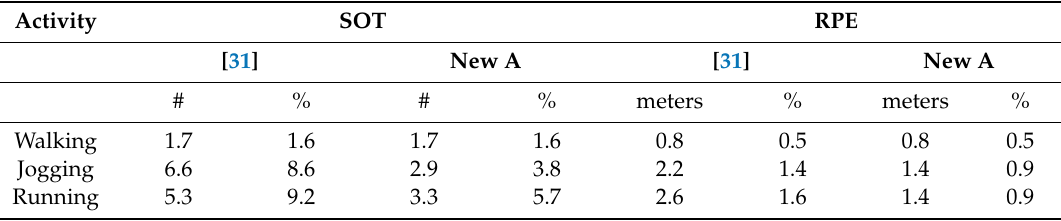
Table 4. Average results of trajectory reconstruction for each type of activity performed by the 10 participants using the previous and the proposed TO and MS detection